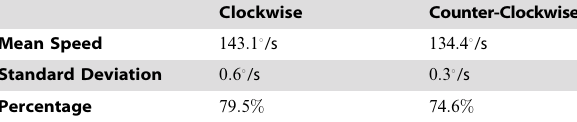
Table 5. Speed of movement of the head direction cell activity packet during testing in the absence of visual input with removal of rotational velocity